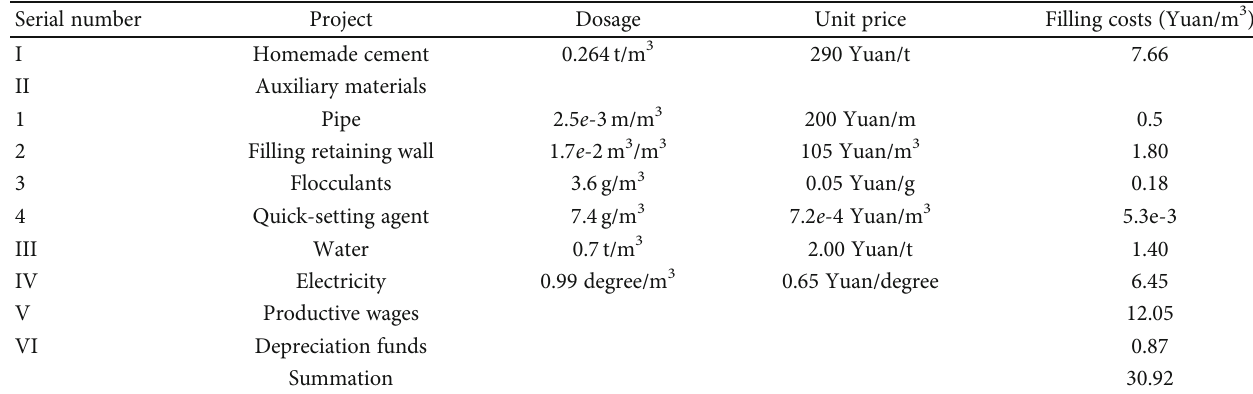
Figure 10: (a, b) The e ff ect of laneway back fi lling. (c, d) The e ff ect of goafs back fi lling. Table 5: The cost of back fi ll